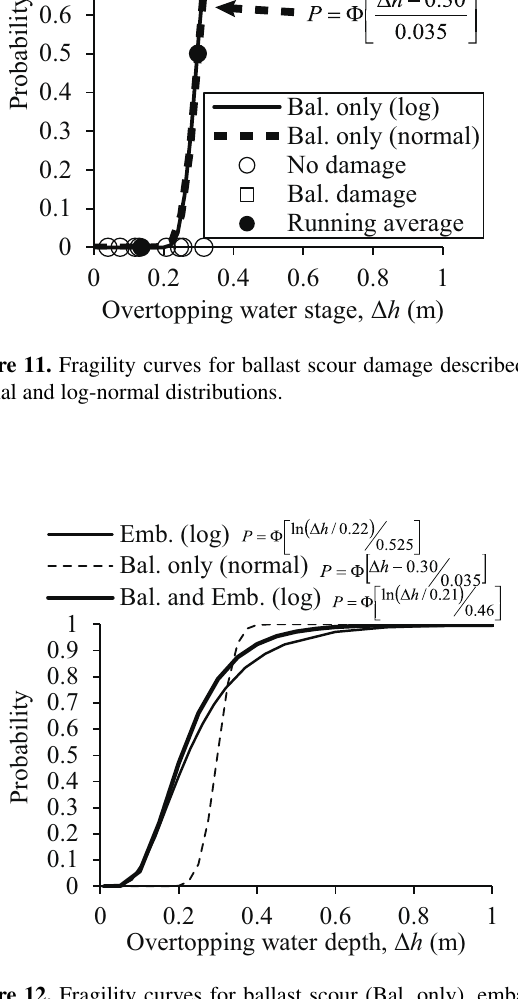
Figure 12. Fragility curves for ballast scour (Bal. only), embank- ment scour (Emb.), and ballast and embankment scour (Bal. and